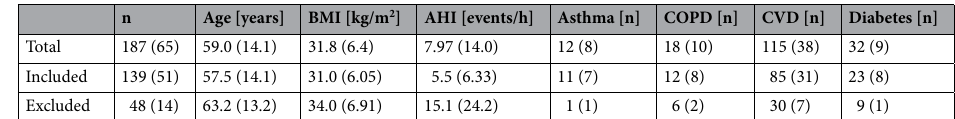
Table 2. Demographic information from study 2 participants. The data is segregated into three rows: one with the demographic information over all study participants (Total), one with the demographic information of participants who passed the data quality assessment (Included in analysis), and one with the demographic information of excluded participants (Excluded from analysis). The columns “n” (participant count), “Asthma”, “COPD”, “CVD” (cardiovascular diseases: arterial hypertension, coronal arterial disease, heart failure, and heart rhythm disorder), “Diabetes” contain the number of participants with diagnosed condition, with the number of females in parenthesis. The columns “Age”, “BMI” (body mass index), “AHI” (apnea–hypopnea index), specify the mean value, with its standard deviation in parenthesis.